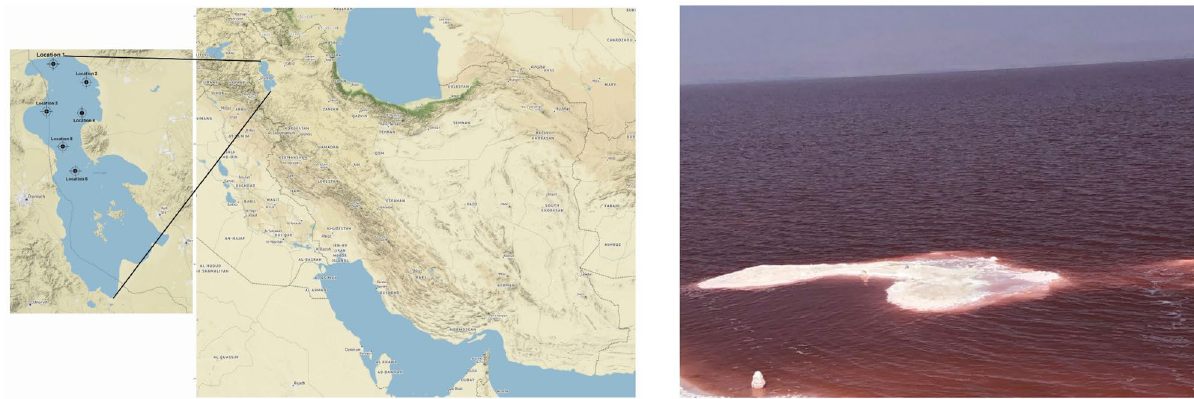
Figure 1. Location of Lake Urmia in Iran and of the six sampling sites. The map was prepared in R studio, using the ggmap 3.0.1 package (left). View of hypersaline Lake Urmia on October 20th, 2020